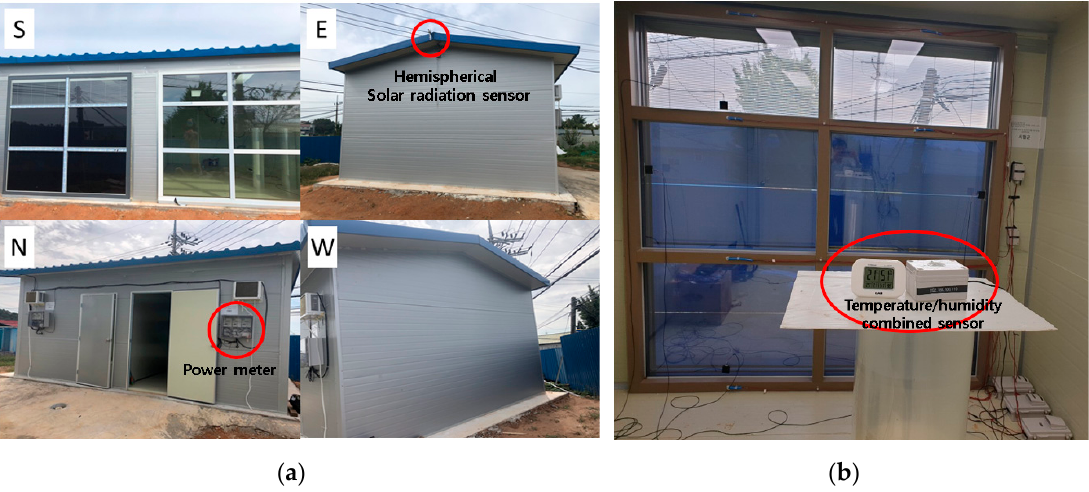
Figure 1. Appearance of testbed in Anseong: ( a ) exterior; ( b ) interior.